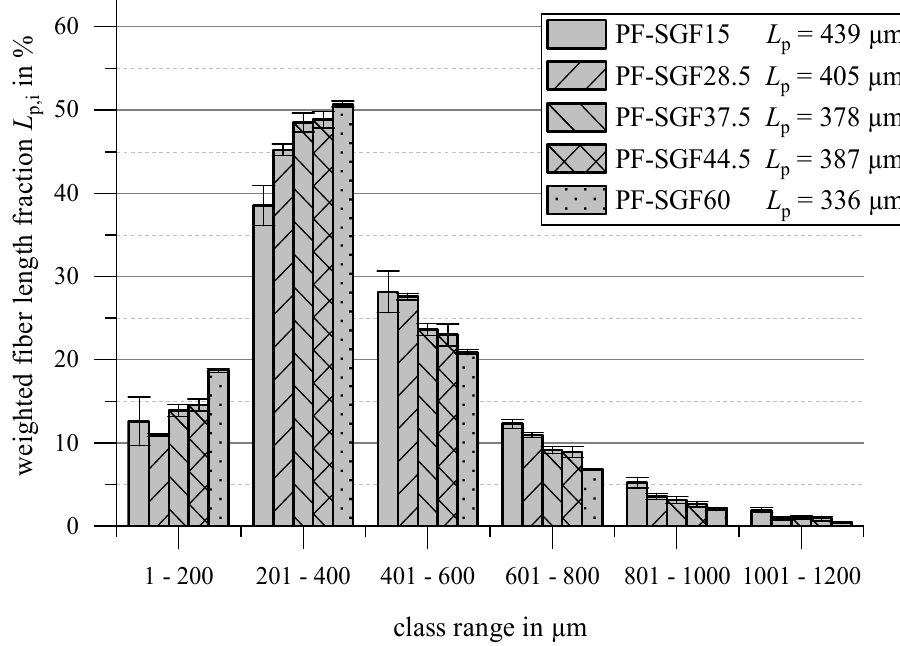
Figure 6. Weighted average fiber length distribution for the short fiber molding compounds. The weighted average fiber length is the highest for the PF-SGF15 formulation at L p = 439 µ m, and drops down to L p = 336 µ m for the PF-SGF60 compound. It can be seen that this compound has the highest fraction of fibers of the two shortest fiber length